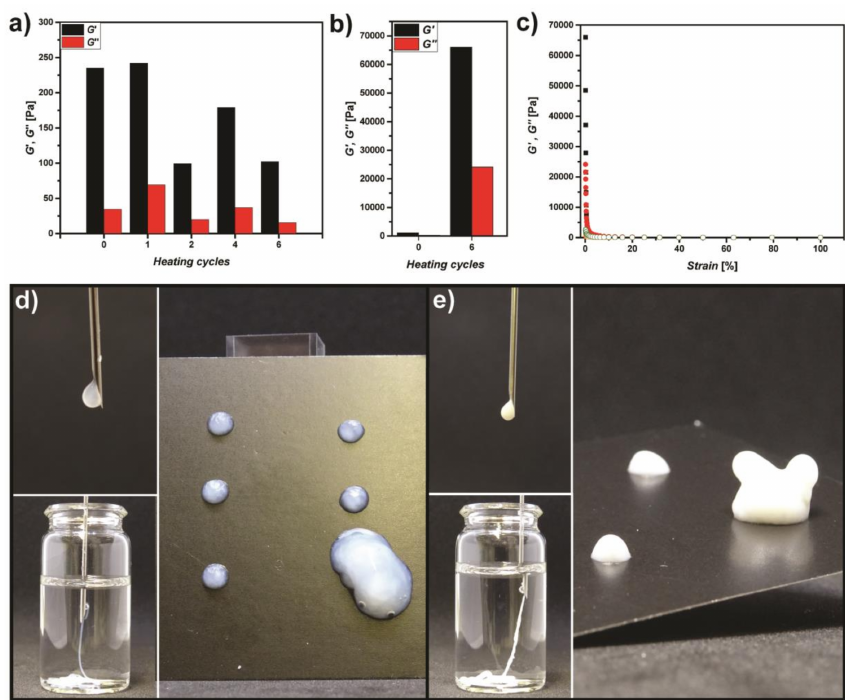
Figure 4. ( a ) Mechanical properties of 3.3 wt.% PVP 41k - b -POEGMA 22k /10.4 wt.% α -CD hydrogel after consecutive heating/cooling cycles between T cp and ambient temperature, ( b )